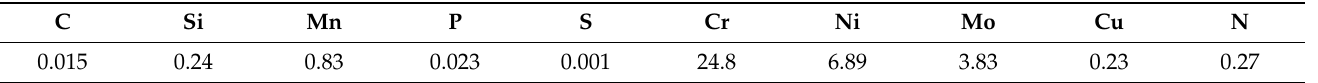
Table 1. The nominal chemical composition of the tested AISI 2507